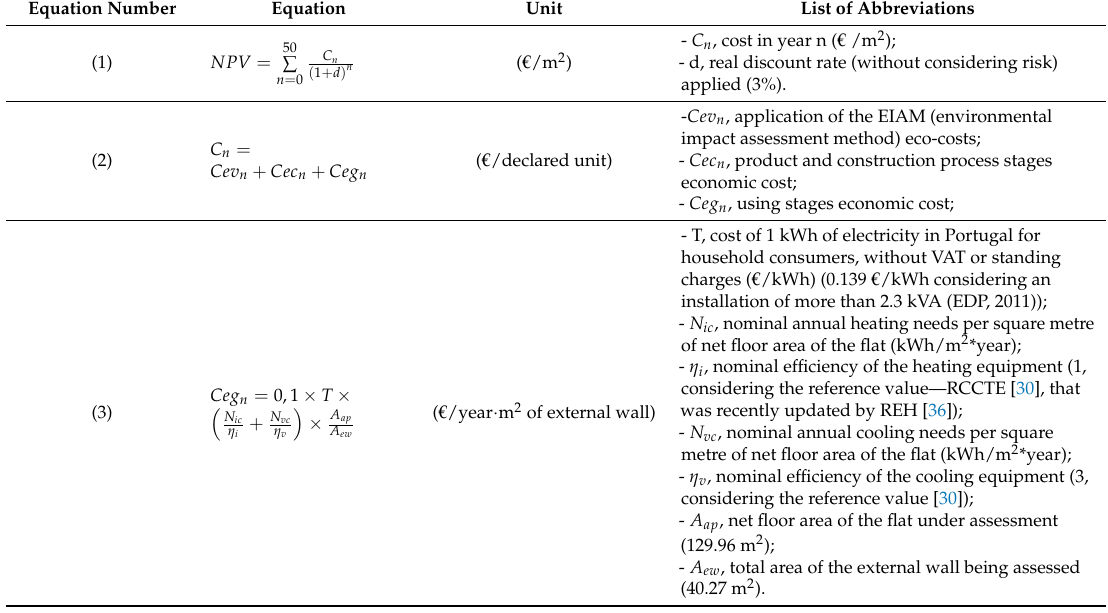
Table 4. Equations ( 1 ), ( 2 ), and ( 3 ) used to determine the NPV value of each